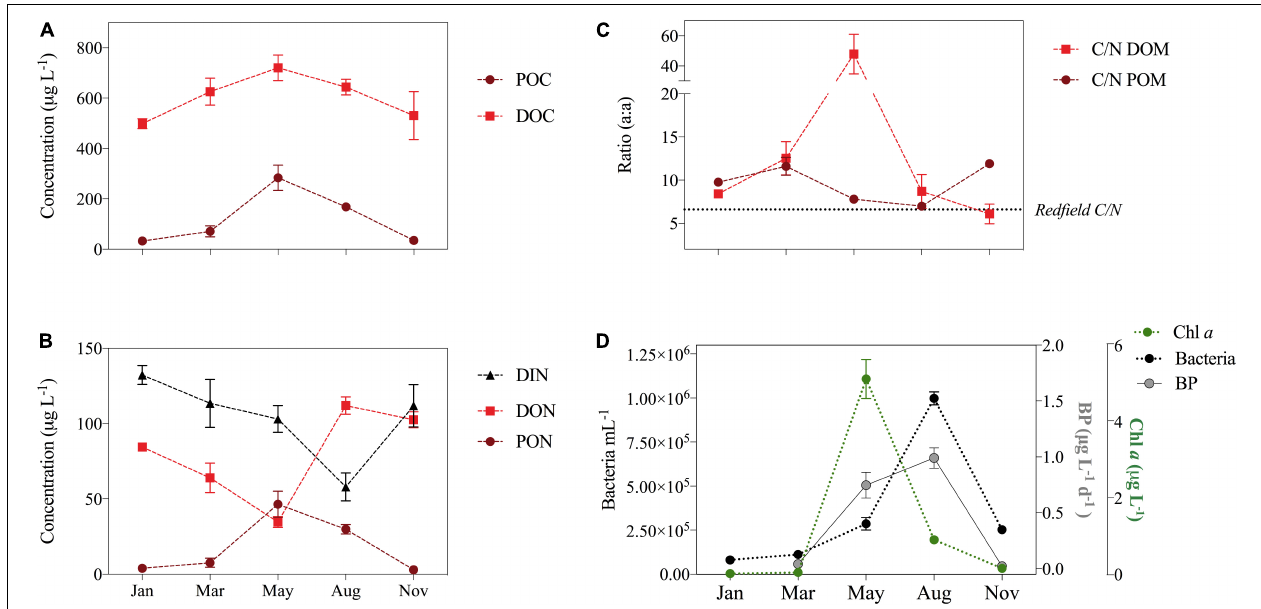
FIGURE 2 | (A) DOC and POC in µ g L − 1 . (B) Inorganic nitrogen (DIN) and organic DON and PON. (C) C/N ratio of DOM and POM (atom:atom), and the dashed line indicates the Redfield ratio. Data is shown as Avg. ± SE calculated within the upper 100 m of the water column at all stations in January, March, May, August, and November. (D) Bacterial abundance (mL − 1 ) (left axis) and concentration of Chl a and bacterial production (BP, µ g L − 1 d − 1 ) (right